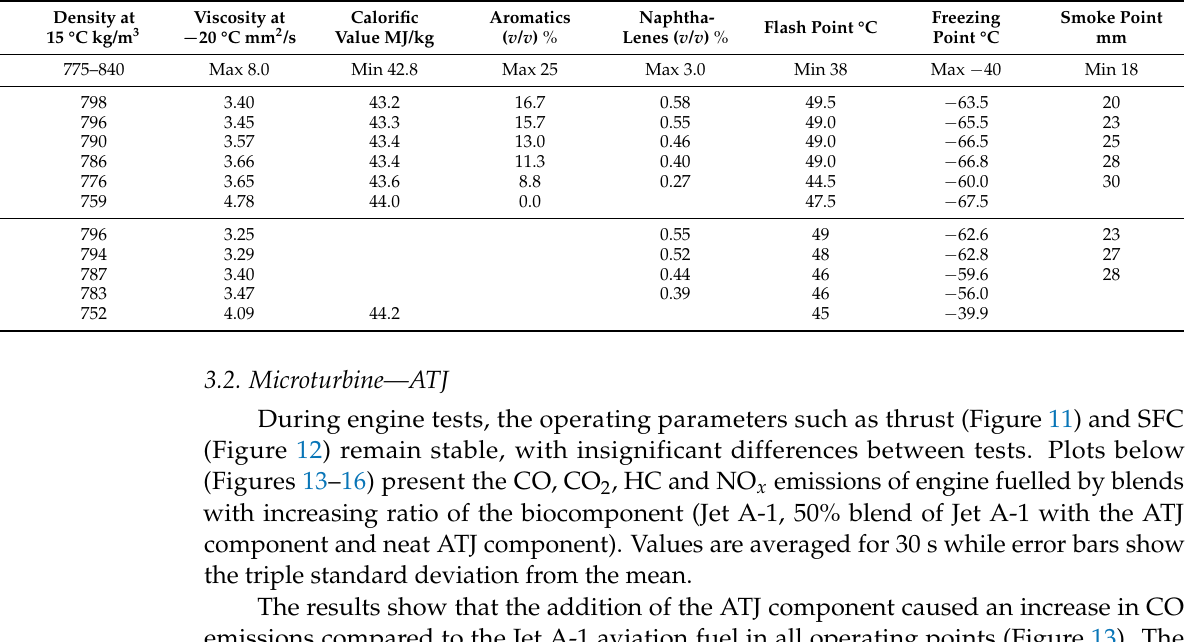
Table 2. Fuel lab testing